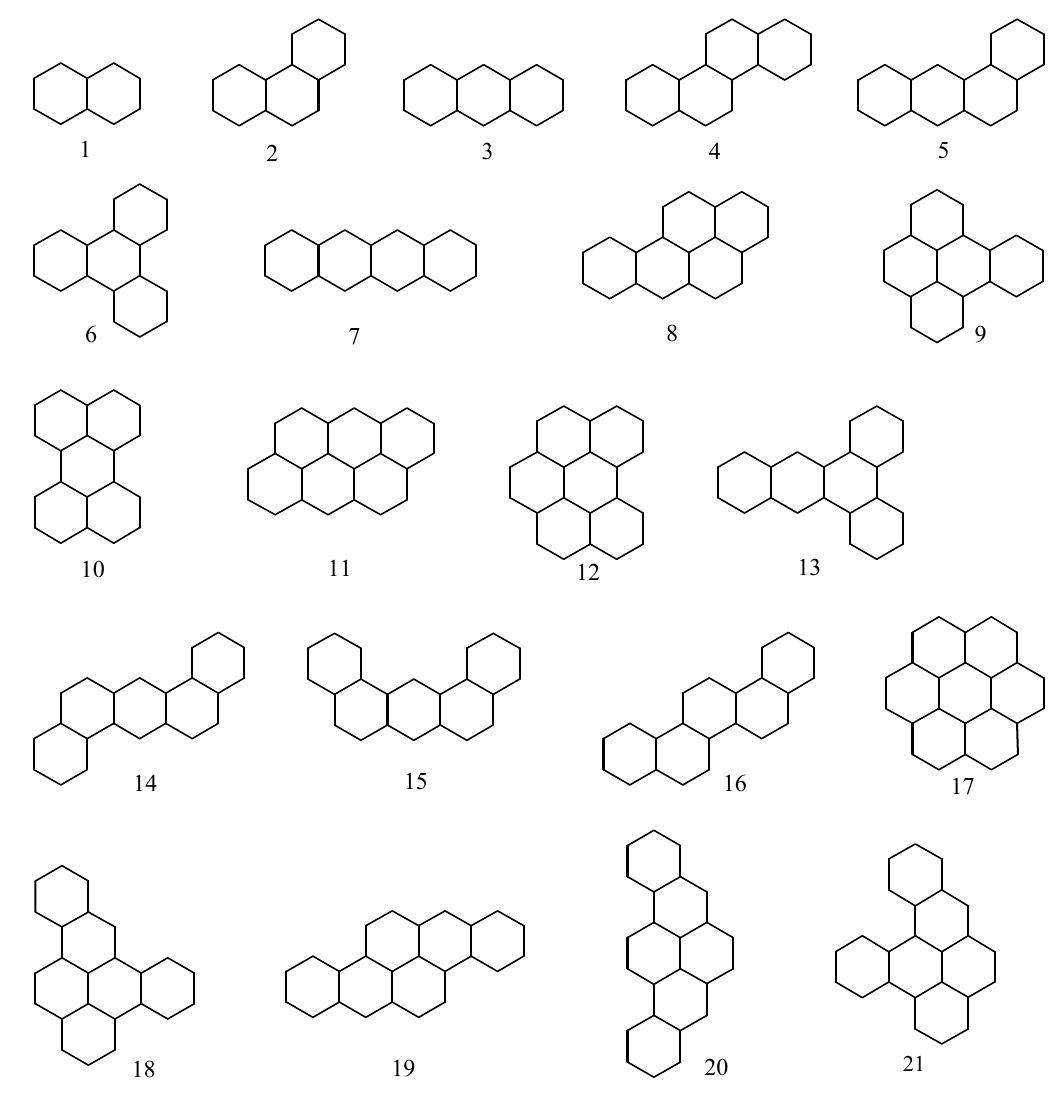
Figure 2. Graphs corresponding to studied benzenoid